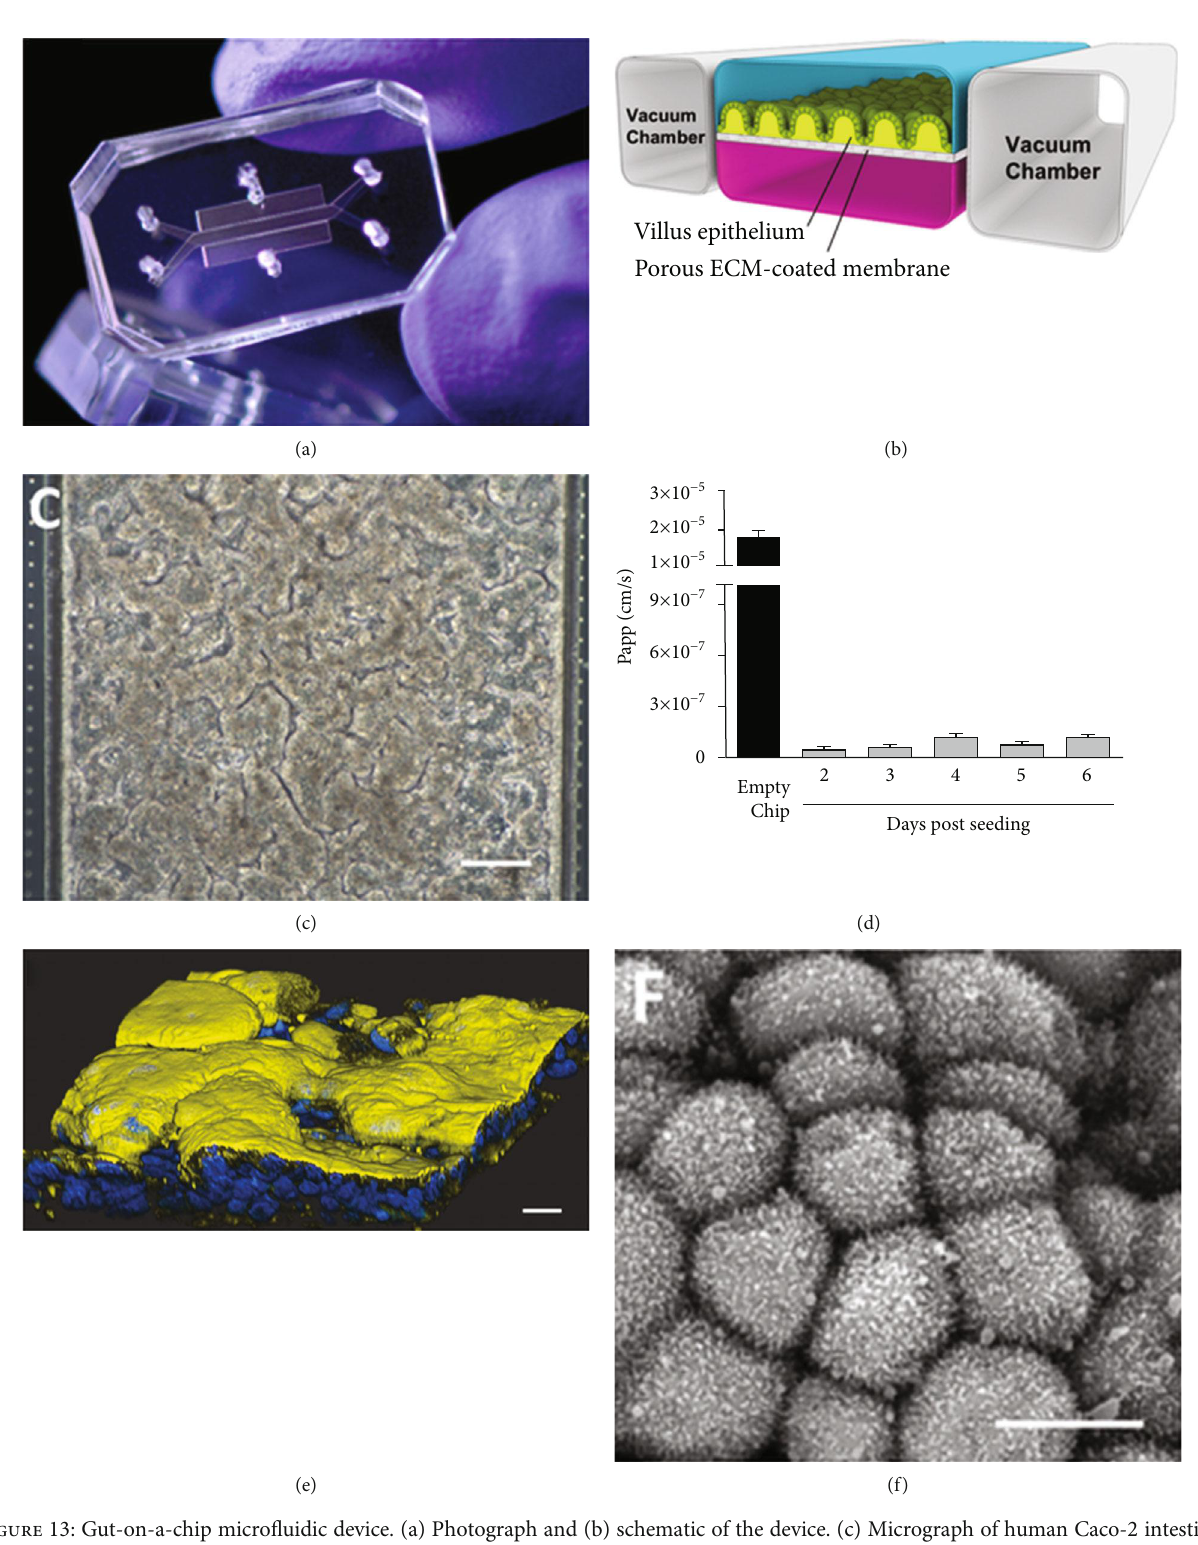
Figure 13: Gut-on-a-chip micro fl uidic device. (a) Photograph and (b) schematic of the device. (c) Micrograph of human Caco-2 intestinal epithelial cells cultured in the device. (d) Apparent permeability (Papp) of the epithelium assessed by adding fl uorescent inulin-FITC. (e) Confocal immuno fl uorescence micrograph of human villus intestinal epithelium formed inside the gut-on-a-chip and stained for villin (yellow). (f) SEM micrographs of the apical surface of the villus epithelium. Reproduced (or adapted) with permission [85], ©2017, Public Library of